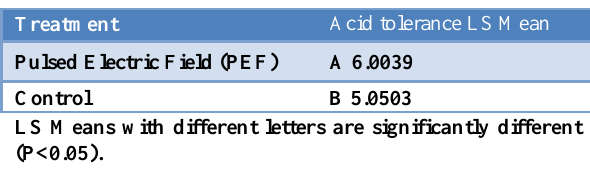
Table, 2: Least square means for acid tolerance of Lactobacillus acidophilus LA-K as influenced by mild pulsed electric field